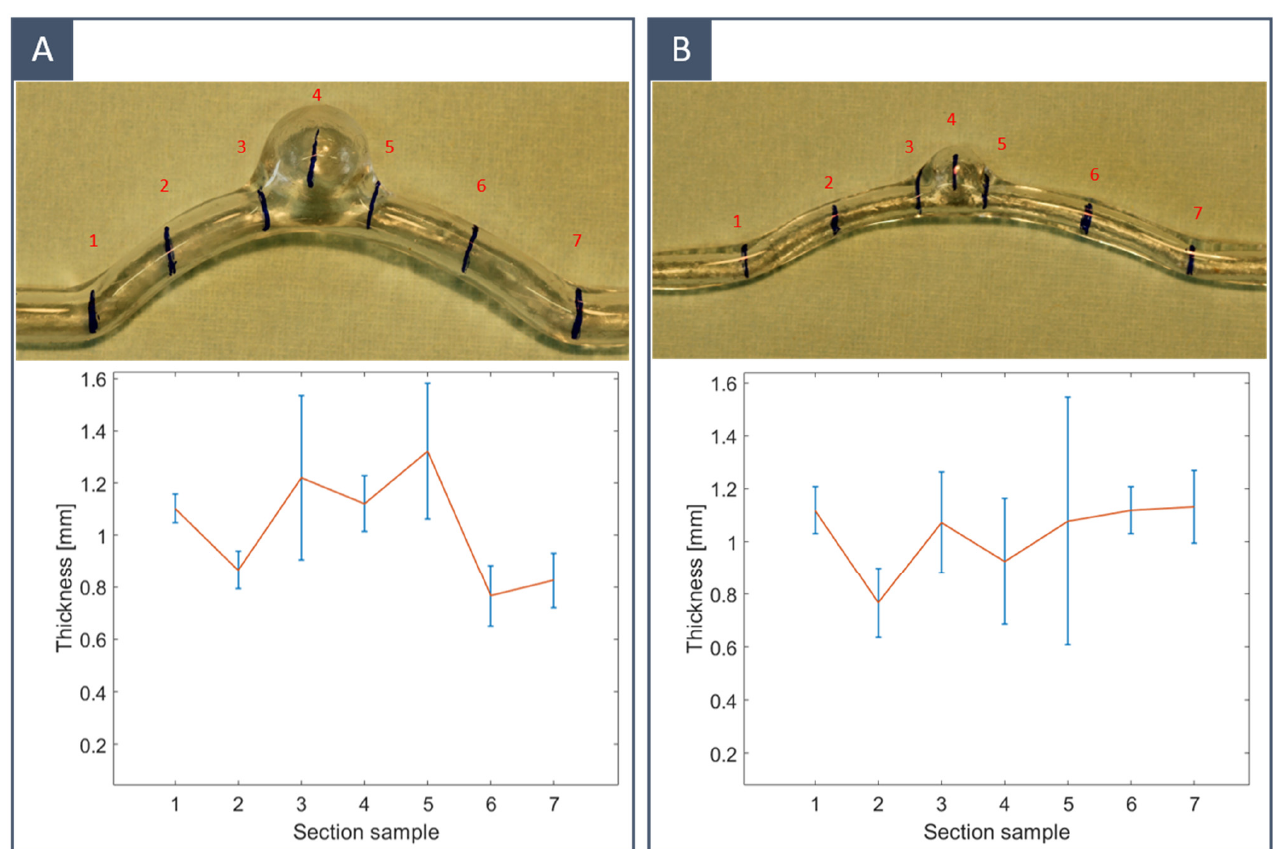
Figure 10. Average thickness (red line) and standard deviation (blue bars) for two idealised models: ( A ) D vessel = 5 mm and ( B ) D vessel = 3 mm. The local thickness of the models was measured with a micrometre (Palmer’s type) at four circumferential points in seven sections (labelled with red numbers) along the longitudinal direction.